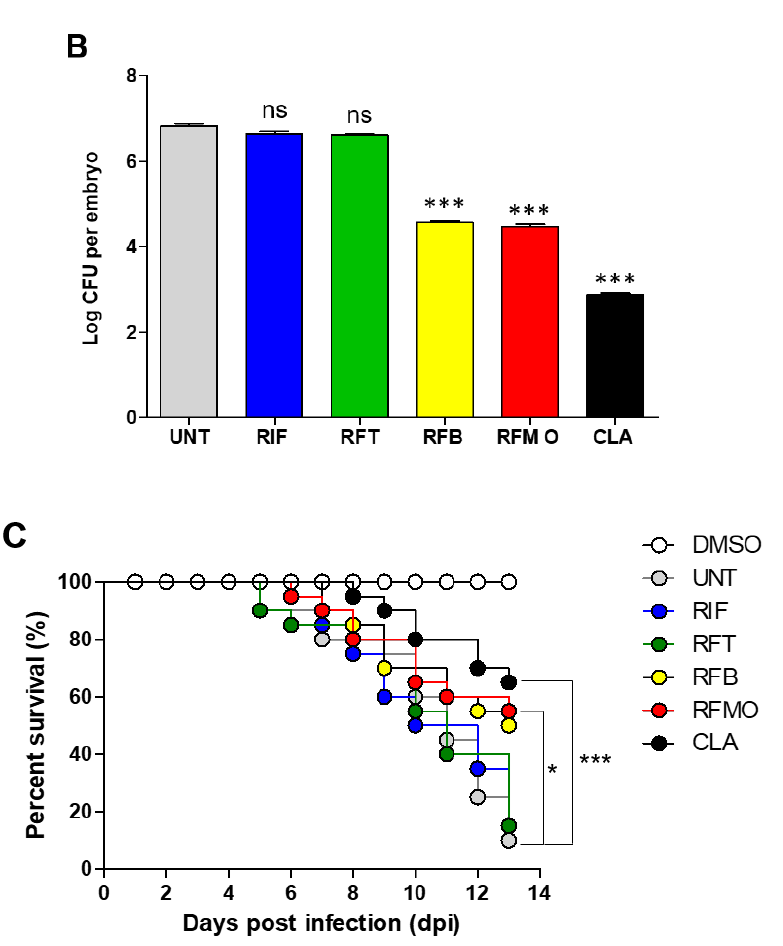
Figure 4. Evaluation of in vivo RFM O activity on M. abscessus CIP 104536 R morphotype expressing mWasabi infection. Zebrafish (ZF) were infected with M. abscessus CIP 104536 T R expressing mWasabi, and treated with different antibiotics. The M. abscessus infected ZF were exposed to RIF, RFT, RFM O, RFB and CLR at a concentration of 25 μM and compared to untreated controls. Green fluorescent protein (GFP) dissemination in ZF was captured using fluorescent microscopy ( A ). The 5 dpi embryos at 25 µM of RIF, RFT, RFM O, RFB and CLR show significant reductions in infection burden (*** P < 0.0001; ns, not significant) ( B ). Survival of M. abscessus -infected embryos treated at 25 μM of rifamycin analogs and clarithromycin ( C ) in comparison with untreated infected embryos and non-treated control ( n = 20, representative of three independent experiments). * P < 0.05, *** P < 0.001.